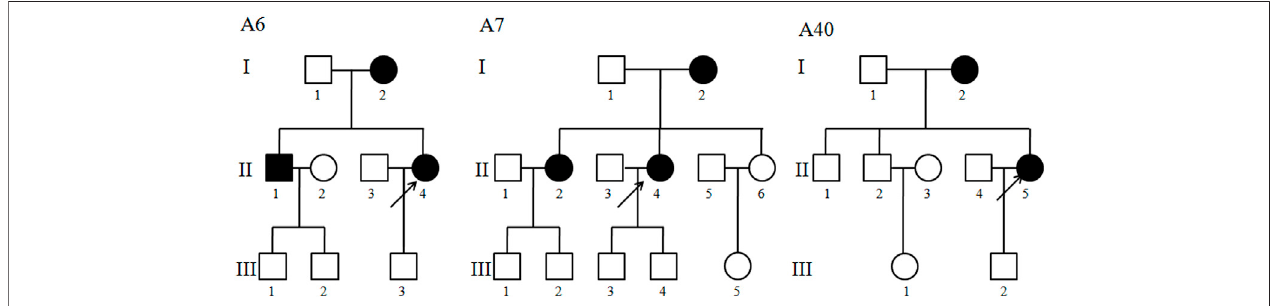
FIGURE 1 | Three Han Chinese pedigrees with cholecystolithiasis. Cholecystolithiasis individuals are indicated by fi lled symbols. An arrow denotes